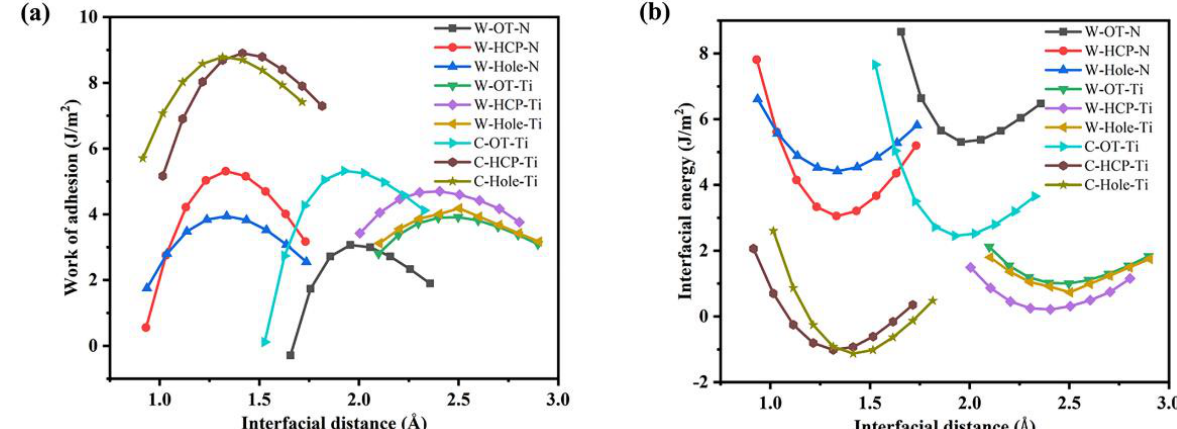
Figure 9. The relation curves of ( a ) d 0 -W ad and ( b ) d 0 - γ of different interface models. Table 6. Interface ideal W ad , γ and d 0 for the nine WC(0001)/TiN(111) interface structure. Termination Stacking